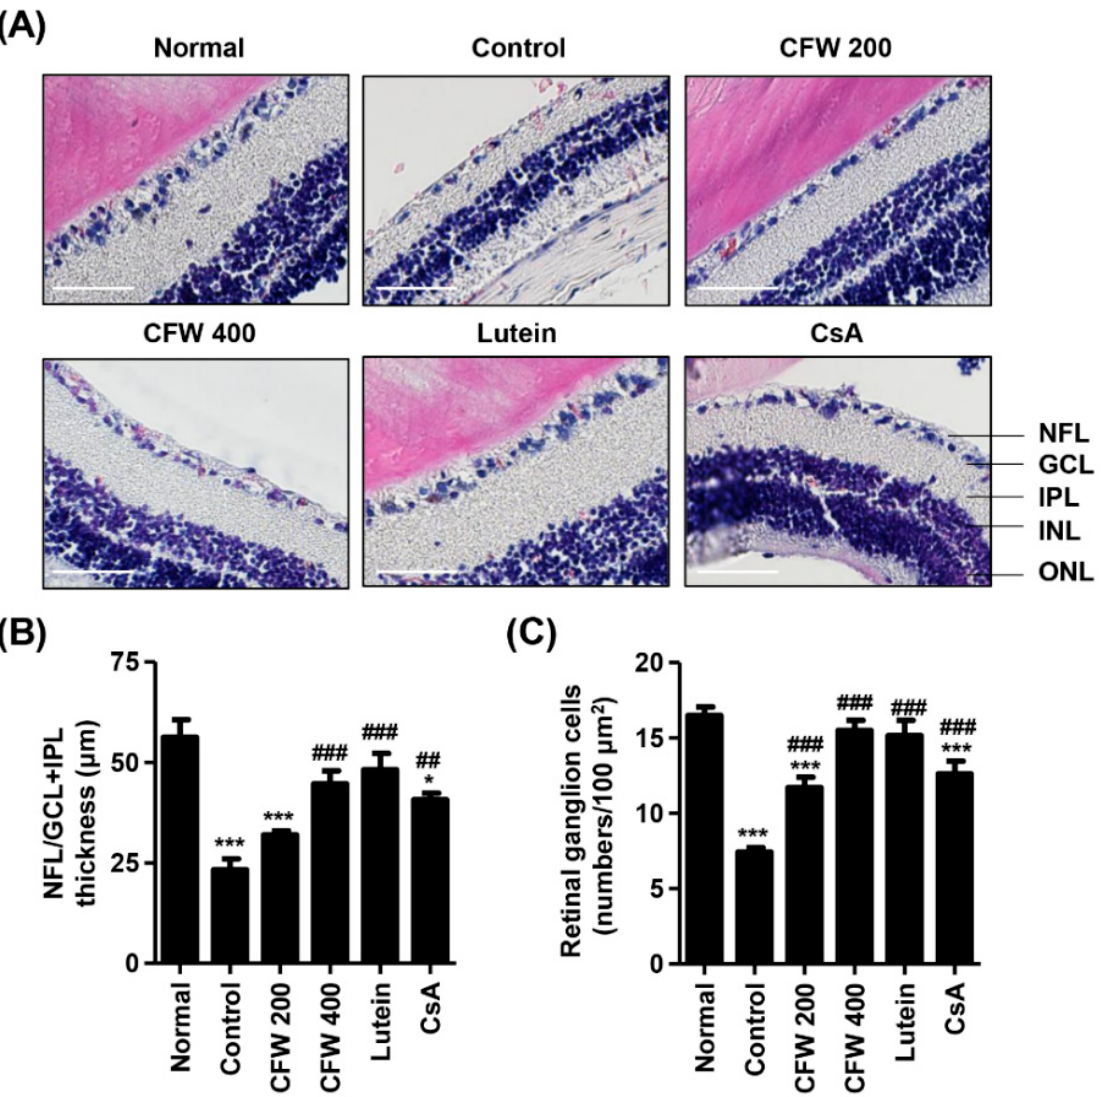
Figure 5. Effect of oral administration of CFW on retinal ganglion cell loss after topical exposure to PM 2.5 in SD rats. ( A ) Representative images of cross-sectioned retina with H&E staining ( n = 5). Nerve fiber layer (NFL), ganglion cell layer (GCL), inner plexiform layer (IPL), inner nuclear layer (INL), and outer nuclear layer (ONL) are indicated. Scale bar, 50 µ m. ( B ) Thickness of NFL/GCL + IPL layers. ( C ) The numbers of cells in GCL of 100 µ m 2 in five different sections were counted. ( B , C ) The data are expressed as the means ± standard deviation ( n = 10). * p < 0.05 and *** p < 0.001 compared to the normal group. ## p < 0.01 and ### p < 0.001 compared to the control group.